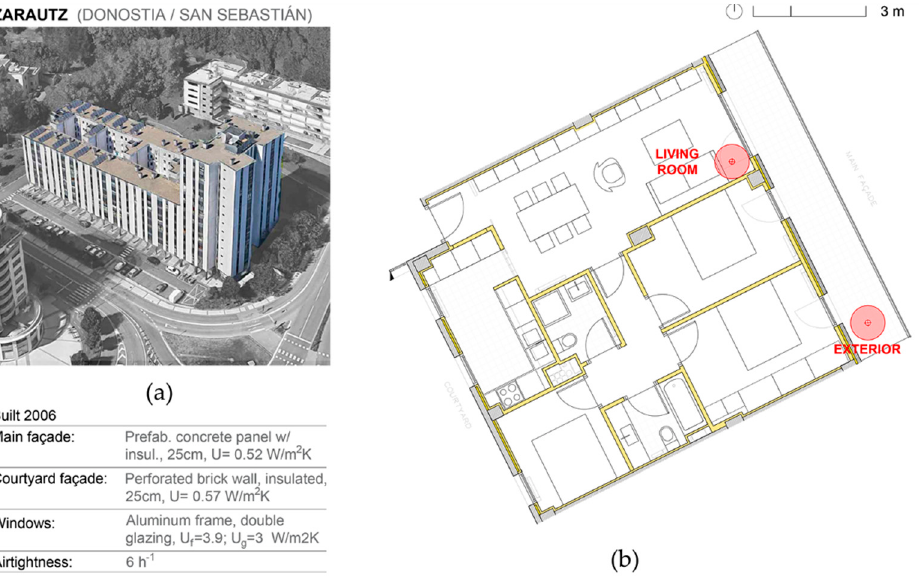
Figure 4. ( a ) Aerial perspective of the Zarautz building. Source: Google Maps. ( b ) Floorplan of the monitored flat on the first floor, with indication of the dataloggers’ locations. Source: authors.